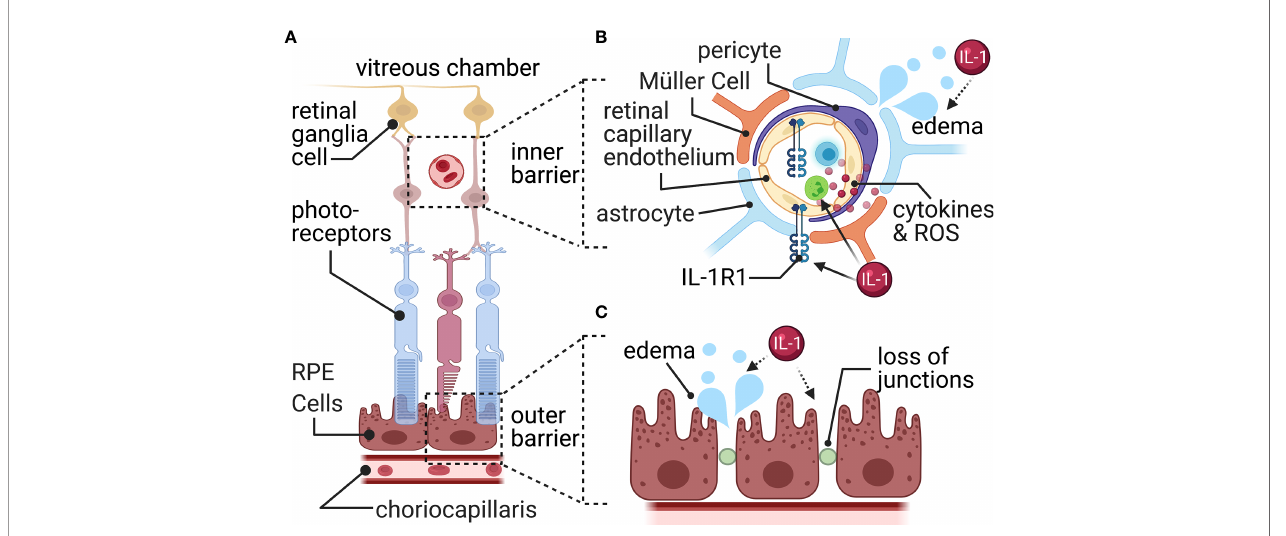
FIGURE 5 | The blood-retina barrier. (A) The blood-retina barrier consists of two separate layers. The fi rst (outer) around the choriocapillaris blood vessels, and the second (inner) around the blood vessels in the retinal ganglia cell layer. (B) The inner barrier consists of endothelial cells surrounded by pericytes, astrocytic end-feet, and specialized glial cells called Müller cells. Here, a TBI increases permeability and results in edema and increased leukocyte in fi ltration. Müller cells pull away from the barrier and activate to release reactive oxygen species (ROS) and cytokines. (C) The retinal pigment epithelial cells (RPE) connected via tight junctions form the outside barrier with the choriocapillaris blood vessels. Here, a TBI causes increased fl uid accumulation through disrupted tight junctions resulting in edema. Most connection with IL-1 signaling is indirect (dashed arrows), while some direct (solid arrow) evidence connects IL-1 signaling with leukocyte traf fi